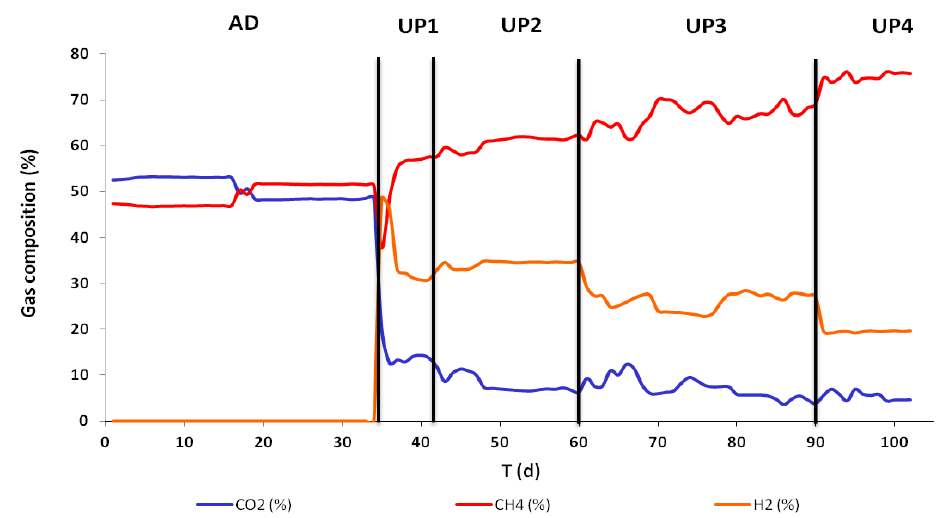
Figure 2. Biogas composition: H 2 , CH 4 , CO 2 (%), during all experimental phases. The substrate was almost completely consumed; indeed, in the reactor effluent, lactose was detected at low concentration (224 ± 13 g L − 1 ) indicating an efficient performance of the AD phase. Acetic acid was the unique VFA detected in the effluent during the AD process, with a concentration of 33 ± 1.8 mg L − 1 . After the AD phase, UP1 started at day 35 by adding H 2 at an injection rate of 1.18 L H2 L R − 1 d − 1 into the reactor. The